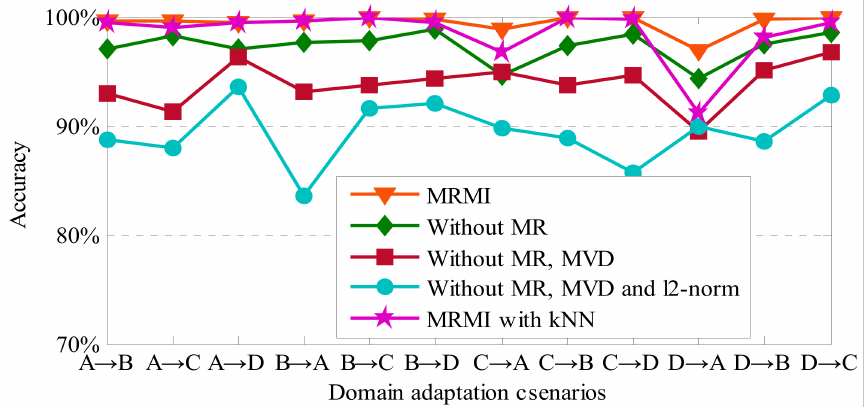
Figure 4. Classification results of single-factor experiments for